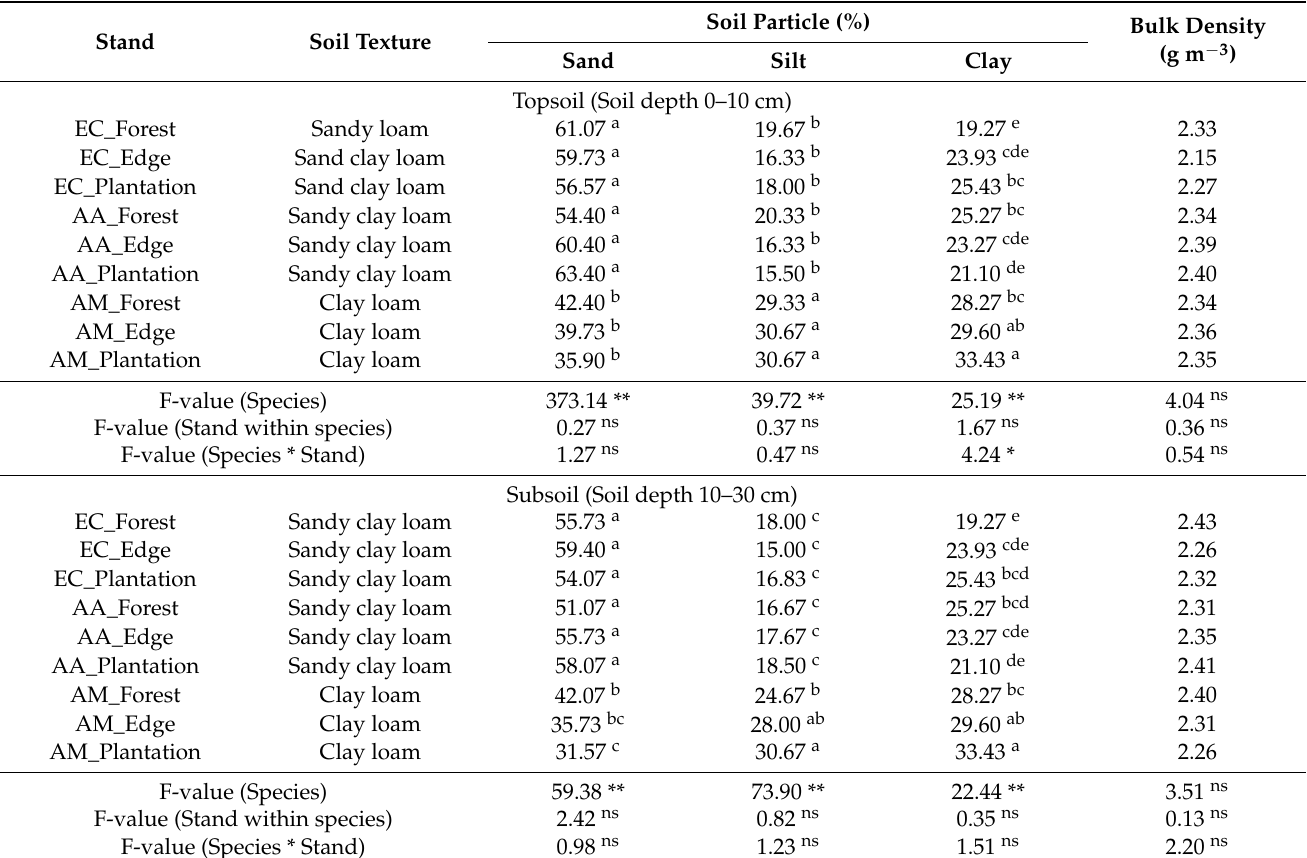
Table 2. Soil physical properties in nine stands along the forest remnants to plantation stands of three exotic plantations. EC: Eucalyptus camaldulensis , AA: Acacia auriculiformis , AM: A. mangium . Significant differences: ns p ≥ 0.05; * p < 0.05, ** p < 0.01. Different superscript letters in the same column indicate significant difference at p <